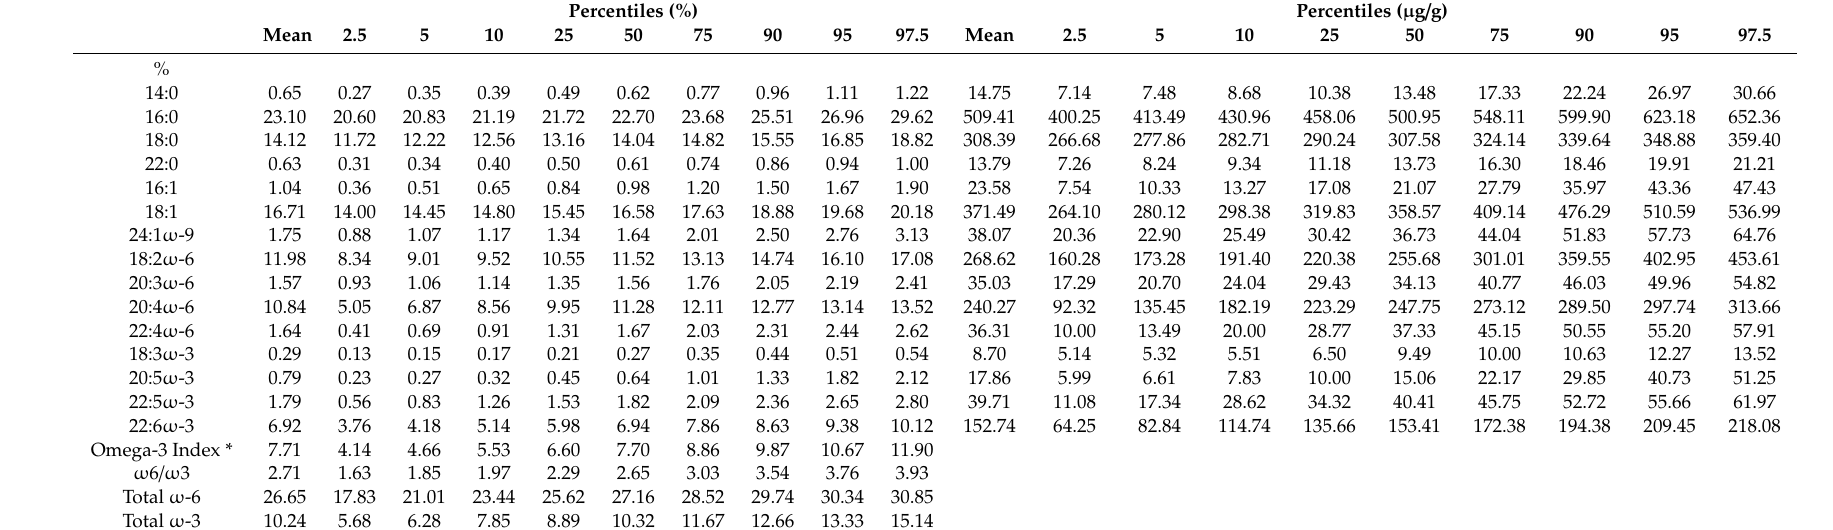
Table 3. Percentiles for selected fatty acids in red blood cells from pregnant women ( n = 247) were recruited all over